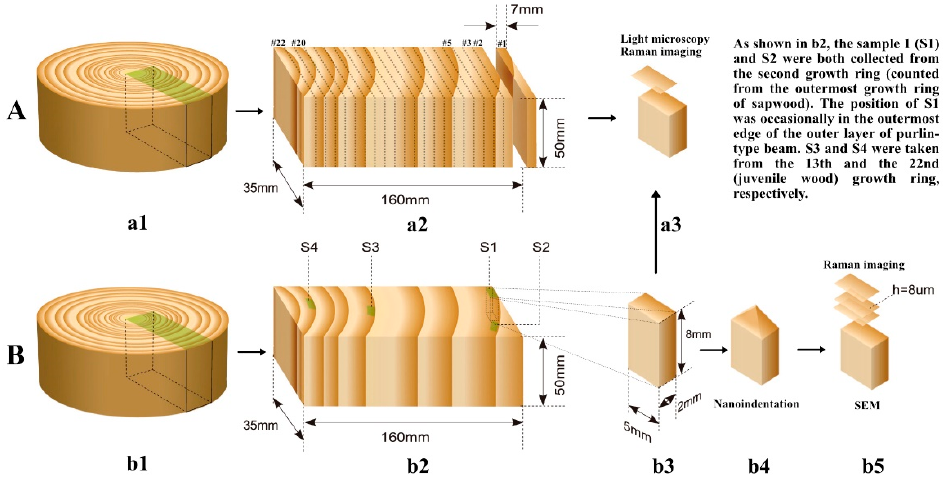
Figure 2. Scheme of preparation of wood samples for measurements. The pictures in row ( A ) indicate the preparation of samples for measurements utilizing microscopical structure analysis, compositional analysis (Numbered #1 to #22 from the outer to the inner part of the wood disc), topochemical distribution by confocal Raman microscopy. The pictures in row ( B ) illustrate the preparation of samples for measurements applying NI, Raman imaging, and SEM.